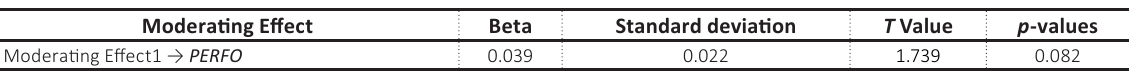
Table 7. Moderating effect of competitive